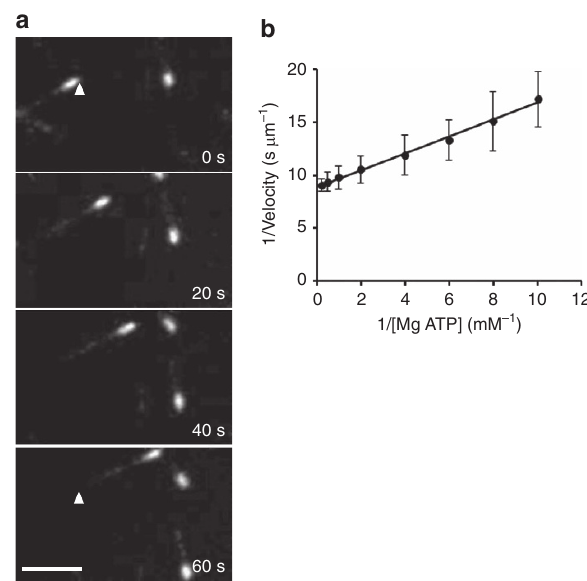
Figure 4 | Characterization of recombinant centralspindlin. ( a ) MTgliding assay of purified centralspindlin. Fluorescence images of MTs moved by centralspindlin immobilized on a coverslip. Polarity-marked MTs (minus-end brighter) move in the gliding assays with velocities of 0.10 m ms (cid:3) 1 . To judge movement, the arrowhead is positioned in the same spot in the first and last panels. MTs move with their minus-end leading, demonstrating that centralspindlin is a plus-end-directed motor. Scale bar, 5 m m. ( b ) Lineweaver–Burk plot displaying the effect of MgATP on MT motility. MTgliding velocities were measured in the presence of increasing MgATP concentrations and plotted as 1/velocity versus. 1/[MgATP].